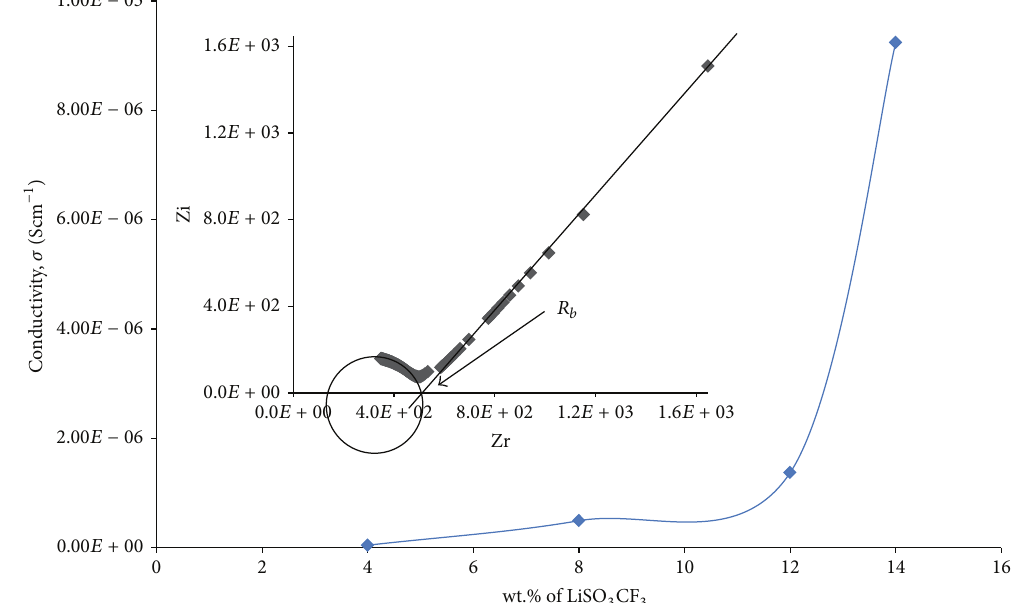
Figure 2: Ionic conductivities of SPE for various wt.% of LiSO 3 CF 3 and impedance plot for sample with the highest conductivity (inset).